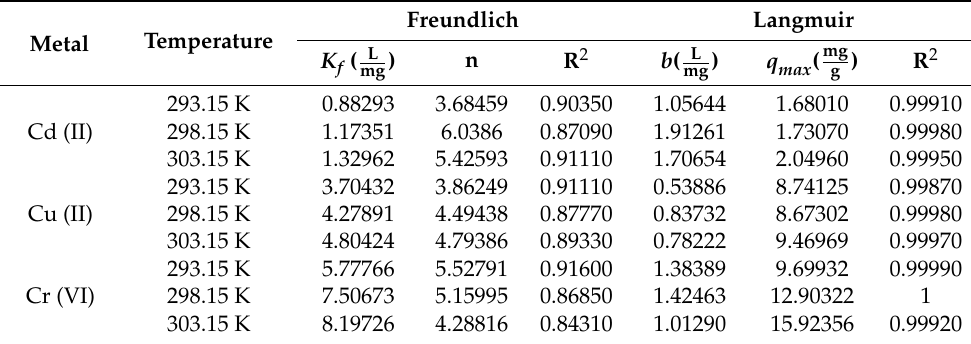
Table 3. Langmuir and Freundlich parameters.